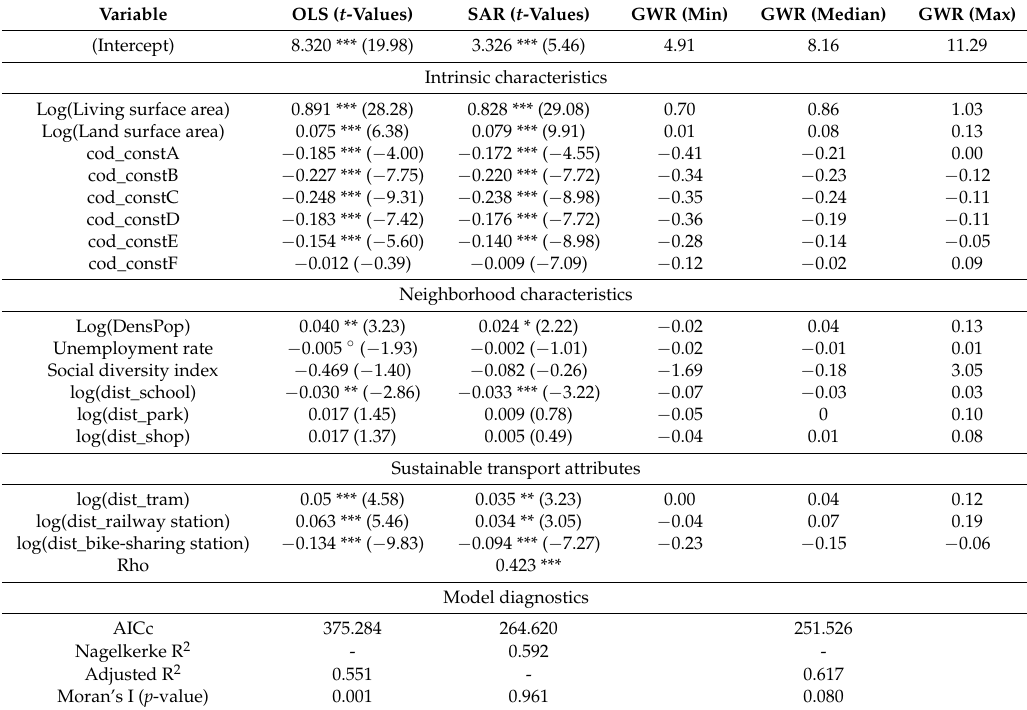
Table 3. Results of estimations for the urban area ( n =